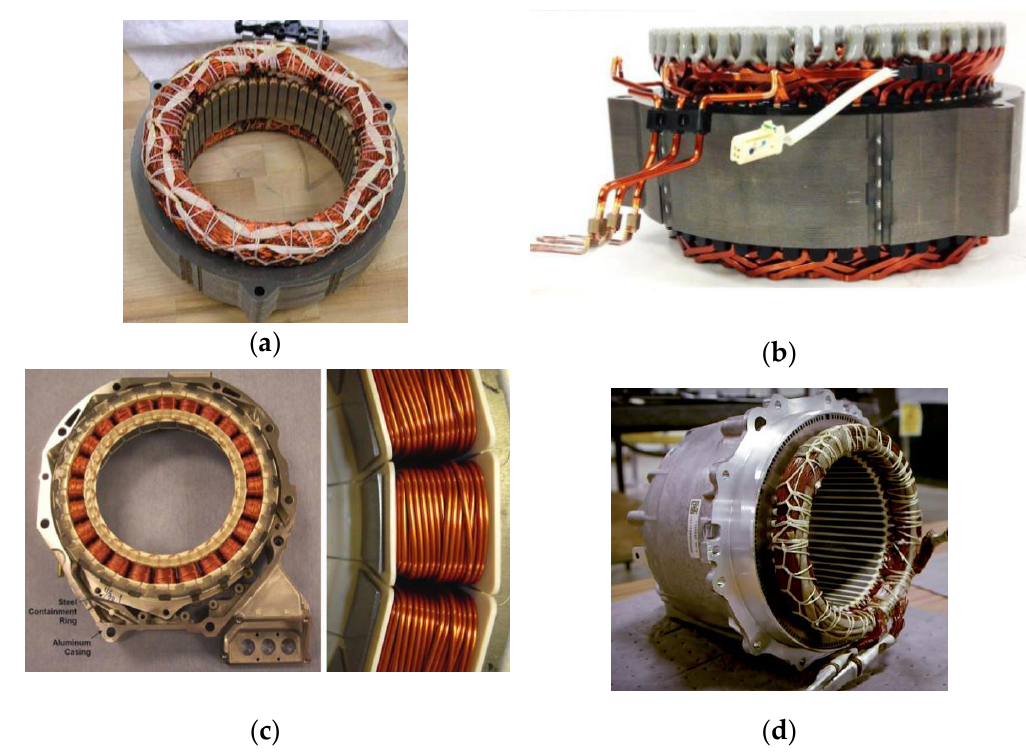
Figure 6. Stator distributed winding design in traction motors for production vehicles: ( a ) 2010 Prius [7], in 2017 the Prius moved to hairpin distributed winding; ( b ) Prius 2017 [8], the hairpin design was also used in Bolt and Spark; ( c ) stator concentrated winding design for production traction machines- Accord 2005 [9]; ( d ) distributed winding in Tesla Model 3 [12].